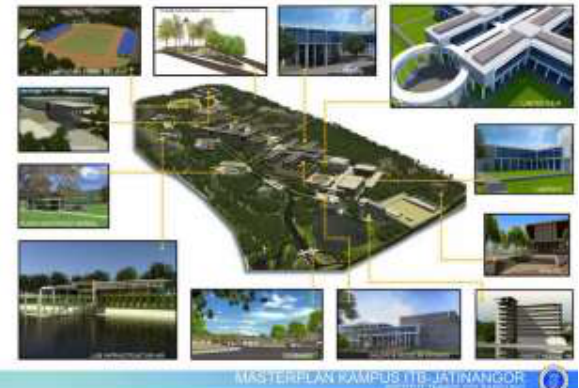
Figure 2. Master plan Jatinangor ITB